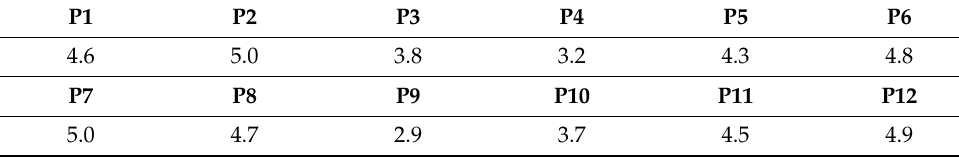
Table 1. Results of the weight sensing experiment